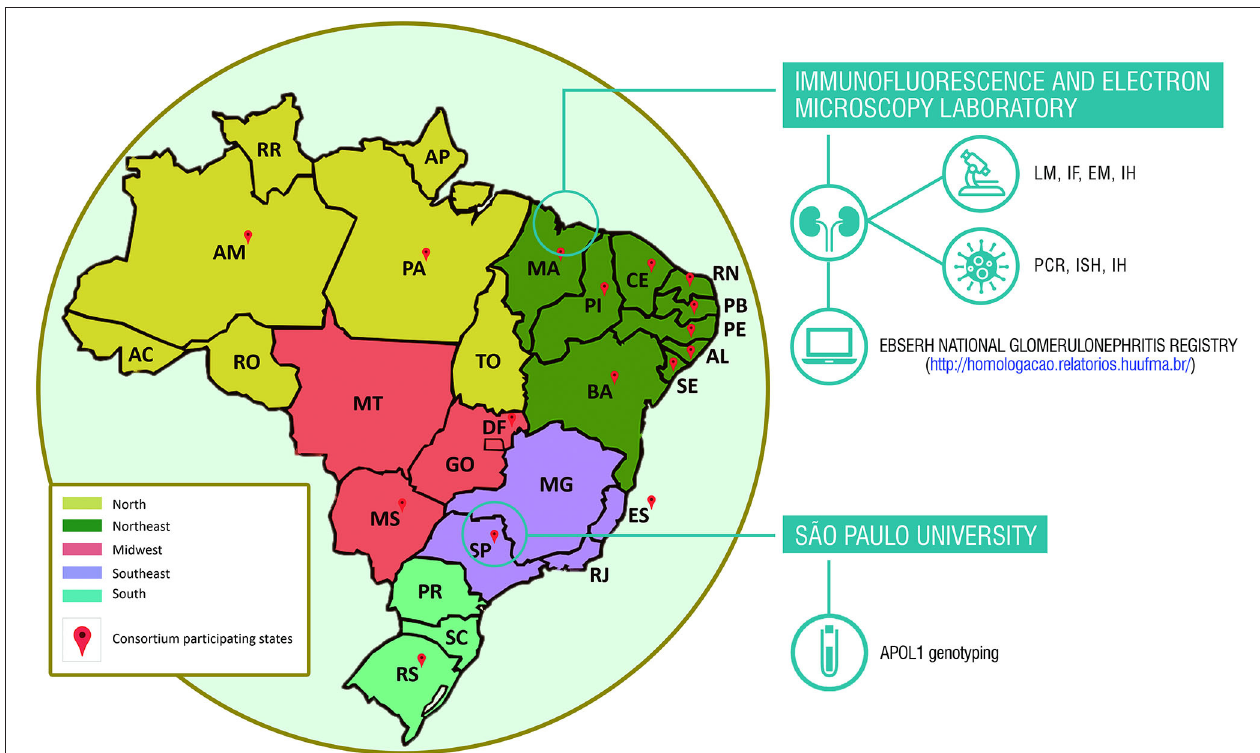
FIGURE 1 | Brazilian states consortium for studies of renal diseases associated with coronavirus disease (COVID-19). APOL1, apolipoprotein L1 gene; EM, electron microscopy; IF, immunofluorescence; IH, immunohistochemistry; ISH, in situ hybridization; LM, light microscopy; PCR, polymerase chain